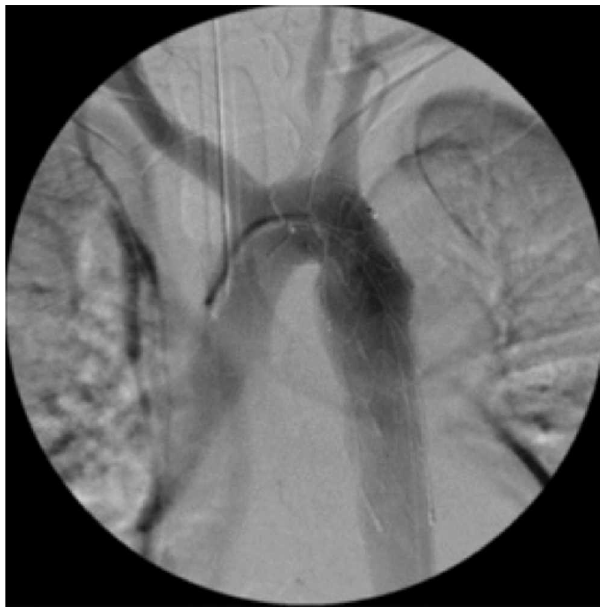
Figure 2 - Immediate post-operative arteriogram.